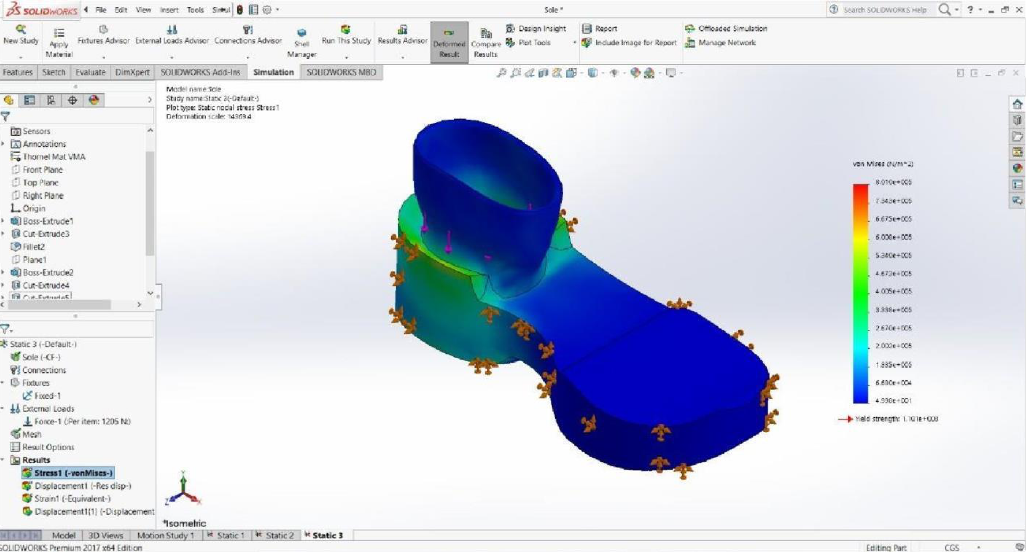
Figure 13. Total von-Mises